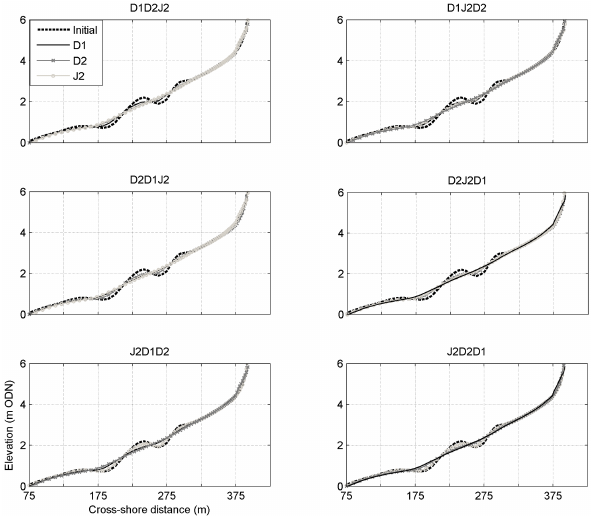
Figure 5. Profile evolution within the selected profile segment (from 75 to 400m in Fig. 4) during each storm event within the six formulated storm